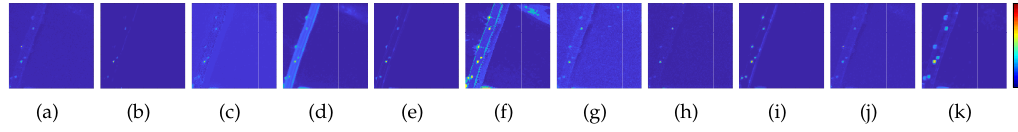
Figure 18. Two-dimensional plots of the detection results obtained by different methods for the Pavia dataset. ( a ) GRX; ( b ) BJSRD; ( c ) LSAD; ( d ) LRASR; ( e ) LSMAD; ( f ) CBAD; ( g ) CRD; ( h ) LRX; ( i ) LKRX; ( j ) OSP; and ( k ) BDSLRR.